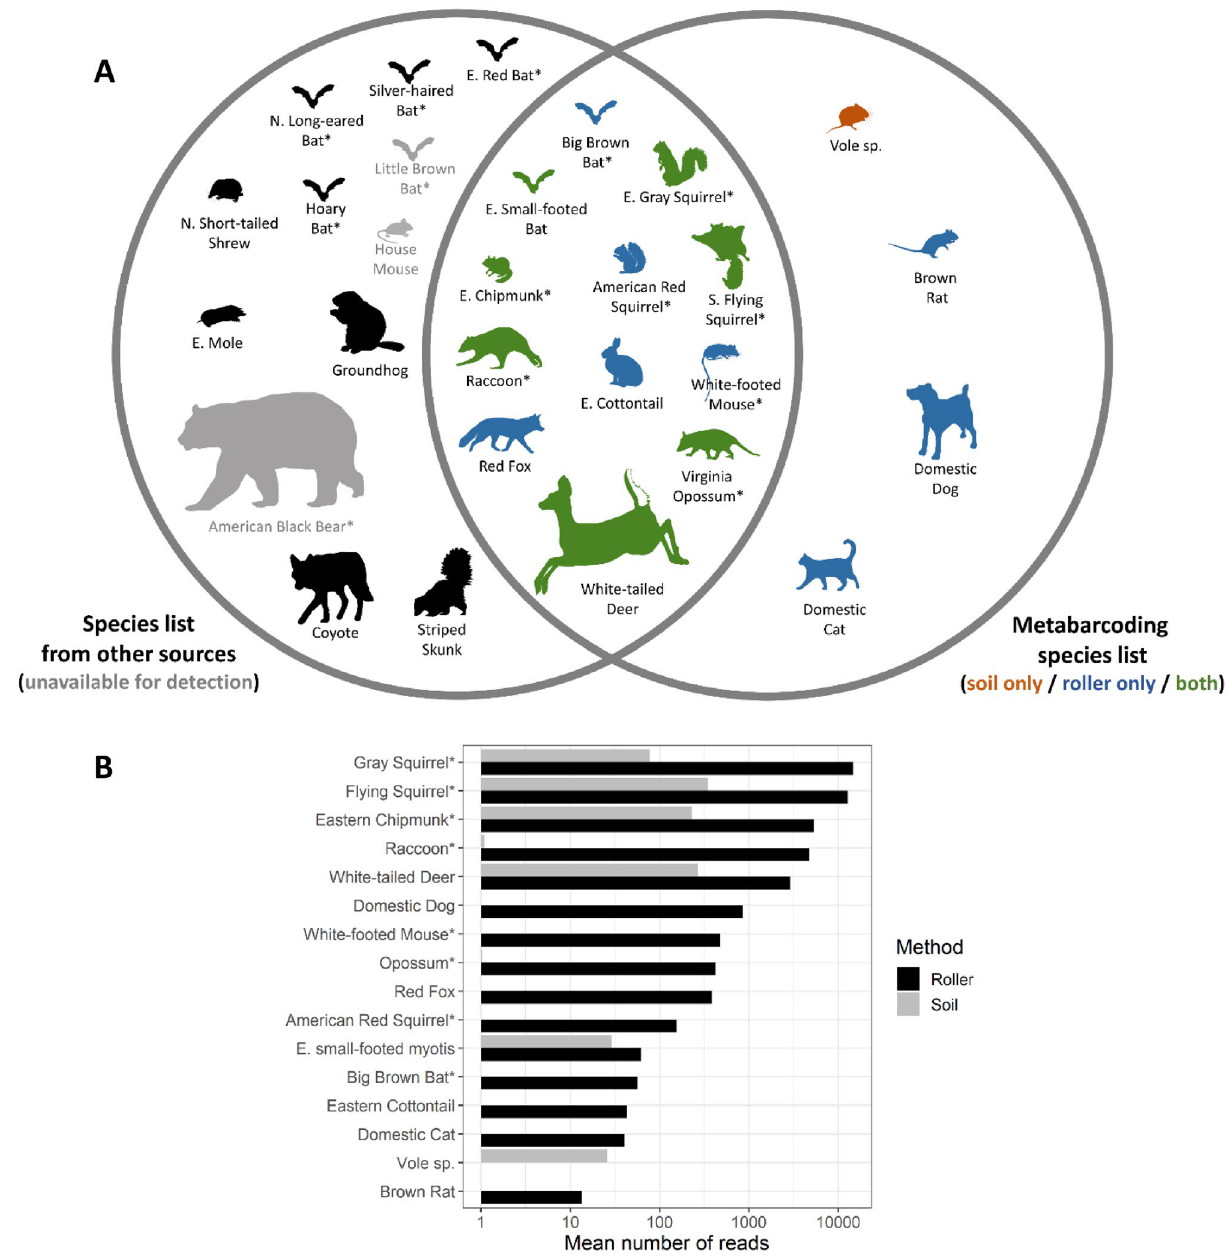
Figure 1. Mammal species detected with eDNA metabarcoding using soil and tree bark surface (‘roller’) sampling in two woodlands in central New Jersey, USA. Venn diagram ( A ) shows which species were detected with metabarcoding (right circle) and which were previously reported as present in the parks (left circle; see Table 1). Color coding: blue—detected with metabarcoding of roller samples only; orange—detected with metabarcoding of soil samples only; green—detected with metabarcoding of both roller and soil samples; black—not detected using metabarcoding; gray—species deemed unavailable for metabarcoding detection due to contamination (mouse and bat) or poor performance of the primer set (bear; see Methods). The bar graph ( B ) shows the mean number of metabarcoding reads per sample for each species detected. Arboreal species are identified with an asterisk (*). Images: www. phylo pic. org (M. Michaud, D. Orr, T. Heath, F. Sayol, C. Schmidt, B. Barnes, A. Wilson, R. Groom, N. Skinner, G. Palomo Munoz, M. Keesey, S.